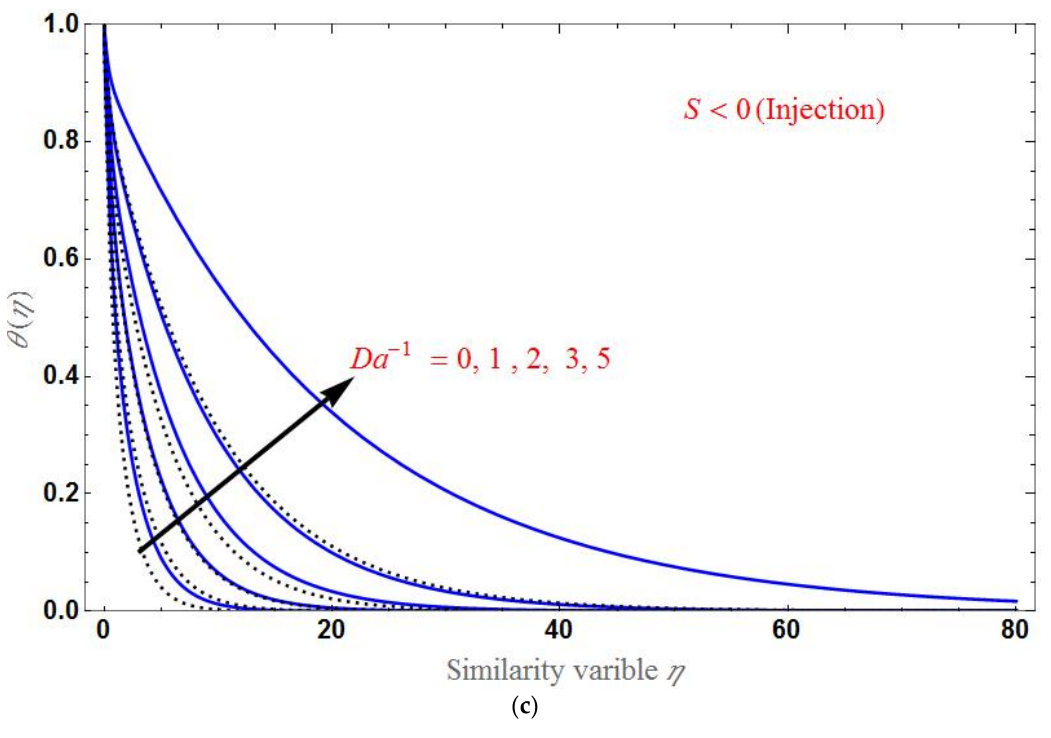
1 Da − Figure 6. The temperature distribution ( )   as a function of  for various values of ( ) − and for three different regimes of S : ( a ) S = 0, ( b ) S = 1, and ( c ) S = −1 . The other fixed parameters are θ η as a function of η for various values of 1 Da Figure 6. The temperature distribution Figure 6. The temperature distribution θ ( η ) as a function of η for various values of Da − 1 and for 1, 0.1, three different regimes of S : ( a ) S = 0, ( b ) S = 1, and ( c ) S = − 1. The other fixed parameters are 1 2 and for three different regimes of S : ( a ) S = 0, ( b ) S = 1, and ( c ) S = − 1. The other fixed parameters are M = Λ = N R = 1, φ 1 = 0.1, φ 2 = 0.04. 1, 0.1, 0.04. M = R 1 2 ( ) θ η Λ Figure 7 shows the temperature profile for different values . We observe ( ) θ η Λ decreases with the enhancement in . Panels (a)–(c) show the regimens of ) 1 S = ) 1 S = −